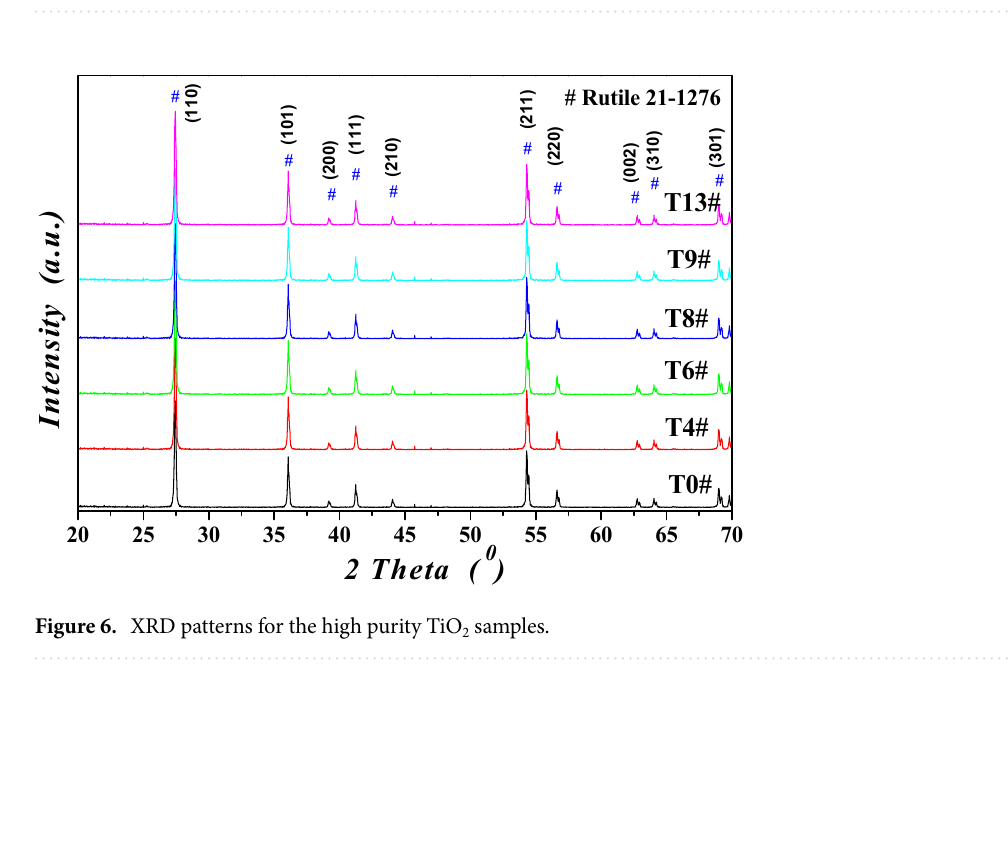
Figure 5. Nitrogen isotherms for the hydrothermal treated metatitanic acid samples.